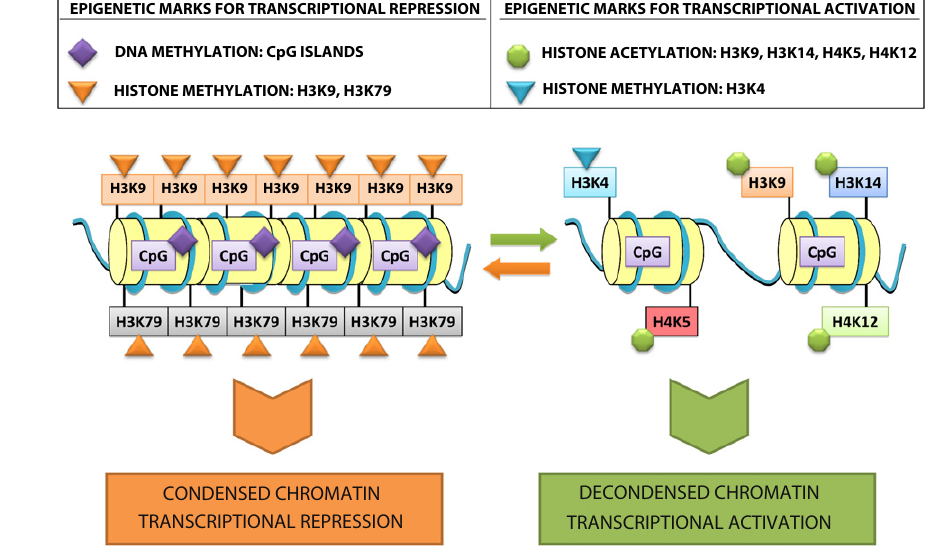
Figure 3. Epigenetic modifications and transcriptional activity. Genes that are transcriptionally inactive are assembled in a compact chromatin structure with methylated DNA, deacetylated histones, and histone H3 methylated in lysine 9 and 79 residues. In contrast, transcriptional activation is characterized by an open chromatin structure composed of undermethylated DNA, histone H3 acetylated on lysine 9 and 14 residues, histone H3 methylated on lysine 4 residues, and histone H4 acetylated on lysine 5 and 12